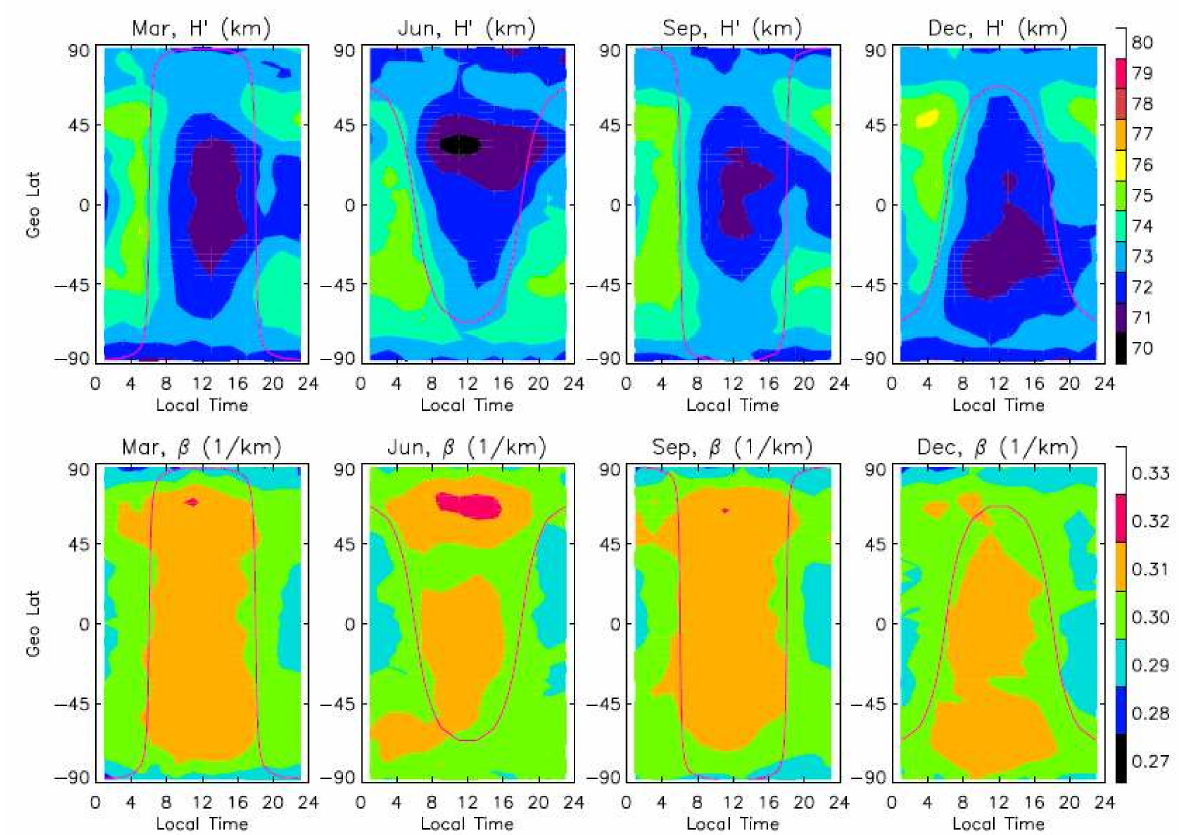
Figure 9. The model parameters ( H (cid:48) and β ) for September and December as a function of magnetic latitude and local time from the fitting of COSMIC-1 D- region (60–80 km) N e to Equation (14). The solid line is the terminator where the solar zenith angle χ at 100 km is equal to 90 ◦